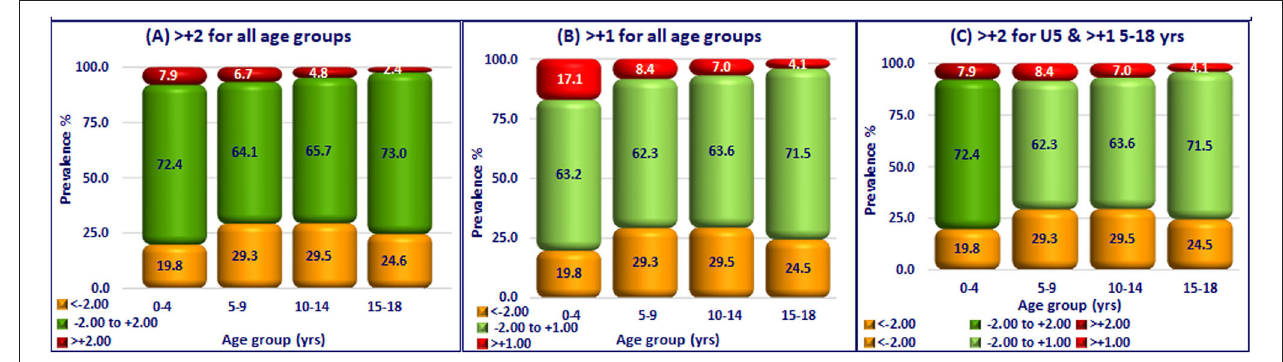
FIGURE 2 | Prevalence of over-nutrition in Indian children (0–18 years). (A) > + 2 for all age groups. (B) > + 1 for all age groups. (C) > + 2 for U5 & > + 15–18